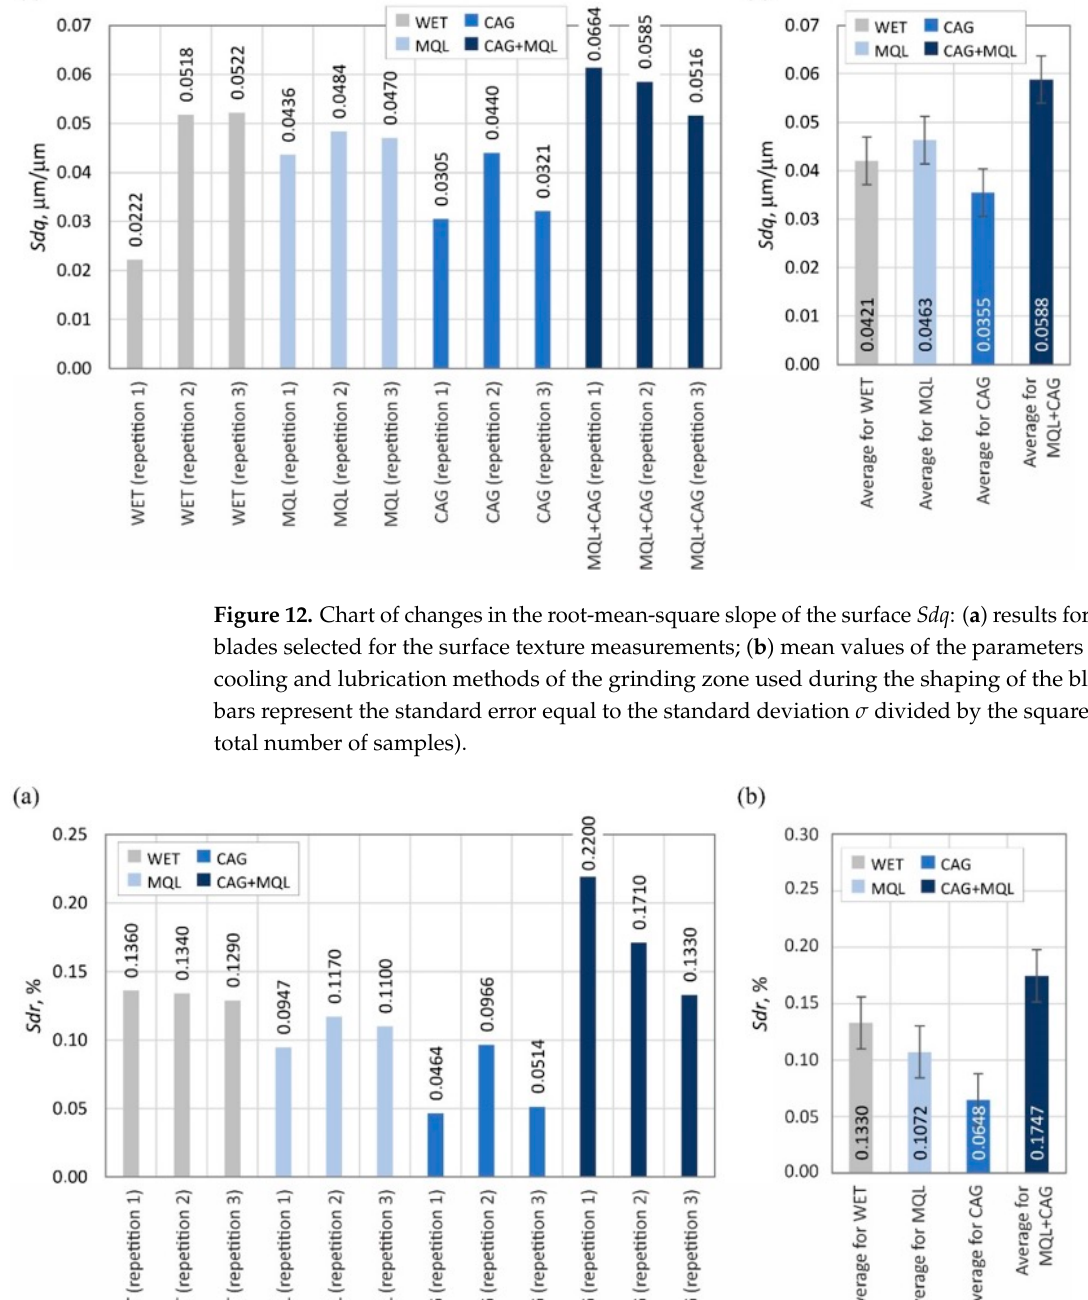
Figure 11. Chart of changes in the texture aspect ratio of the surface Str : ( a ) results for the twelve blades selected for the surface texture measurements; ( b ) mean values of the parameters divided by cooling and lubrication methods of the grinding zone used during the shaping of the blades (error bars represent the standard error equal to the standard deviation σ divided by the square root of the total number of samples).